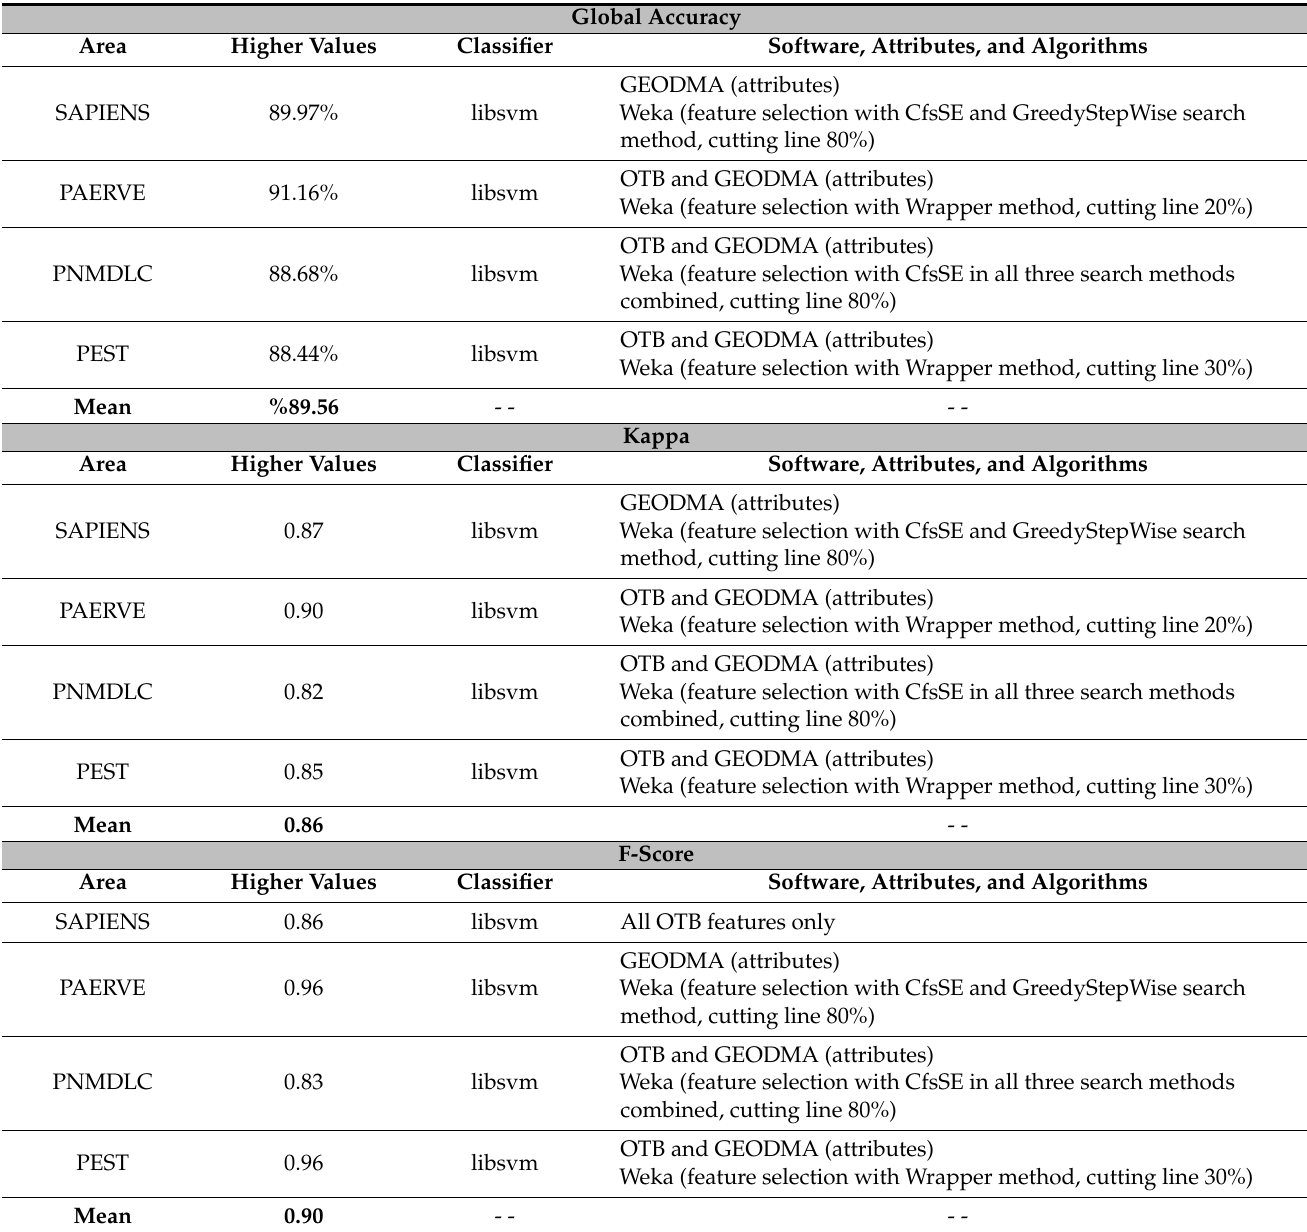
Table 5. Higher values obtained for global accuracy, kappa, and F-score indices for Class 1 ( Pinus sp.) and their respective compositions of software, attributes, and machine learning